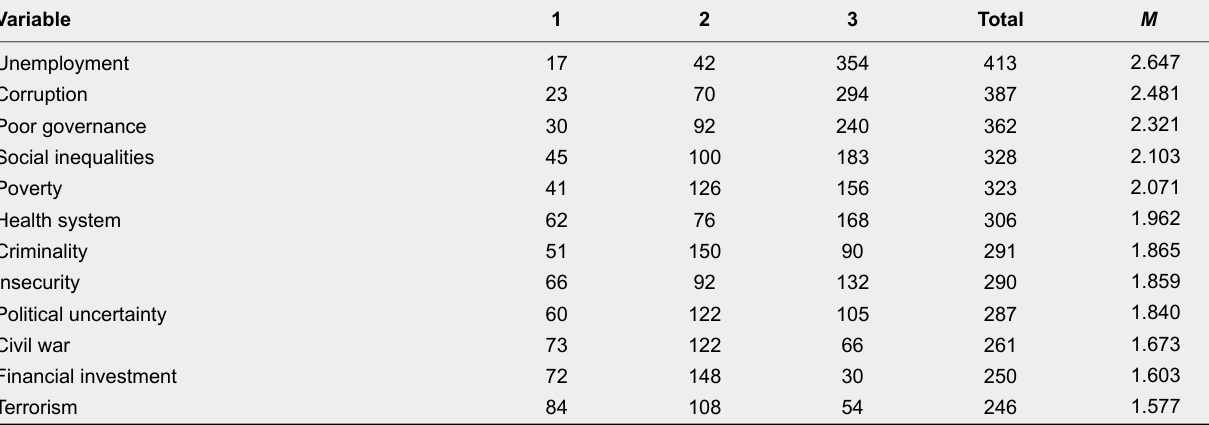
Mean Item Scores on Characterization Questionnaire ii